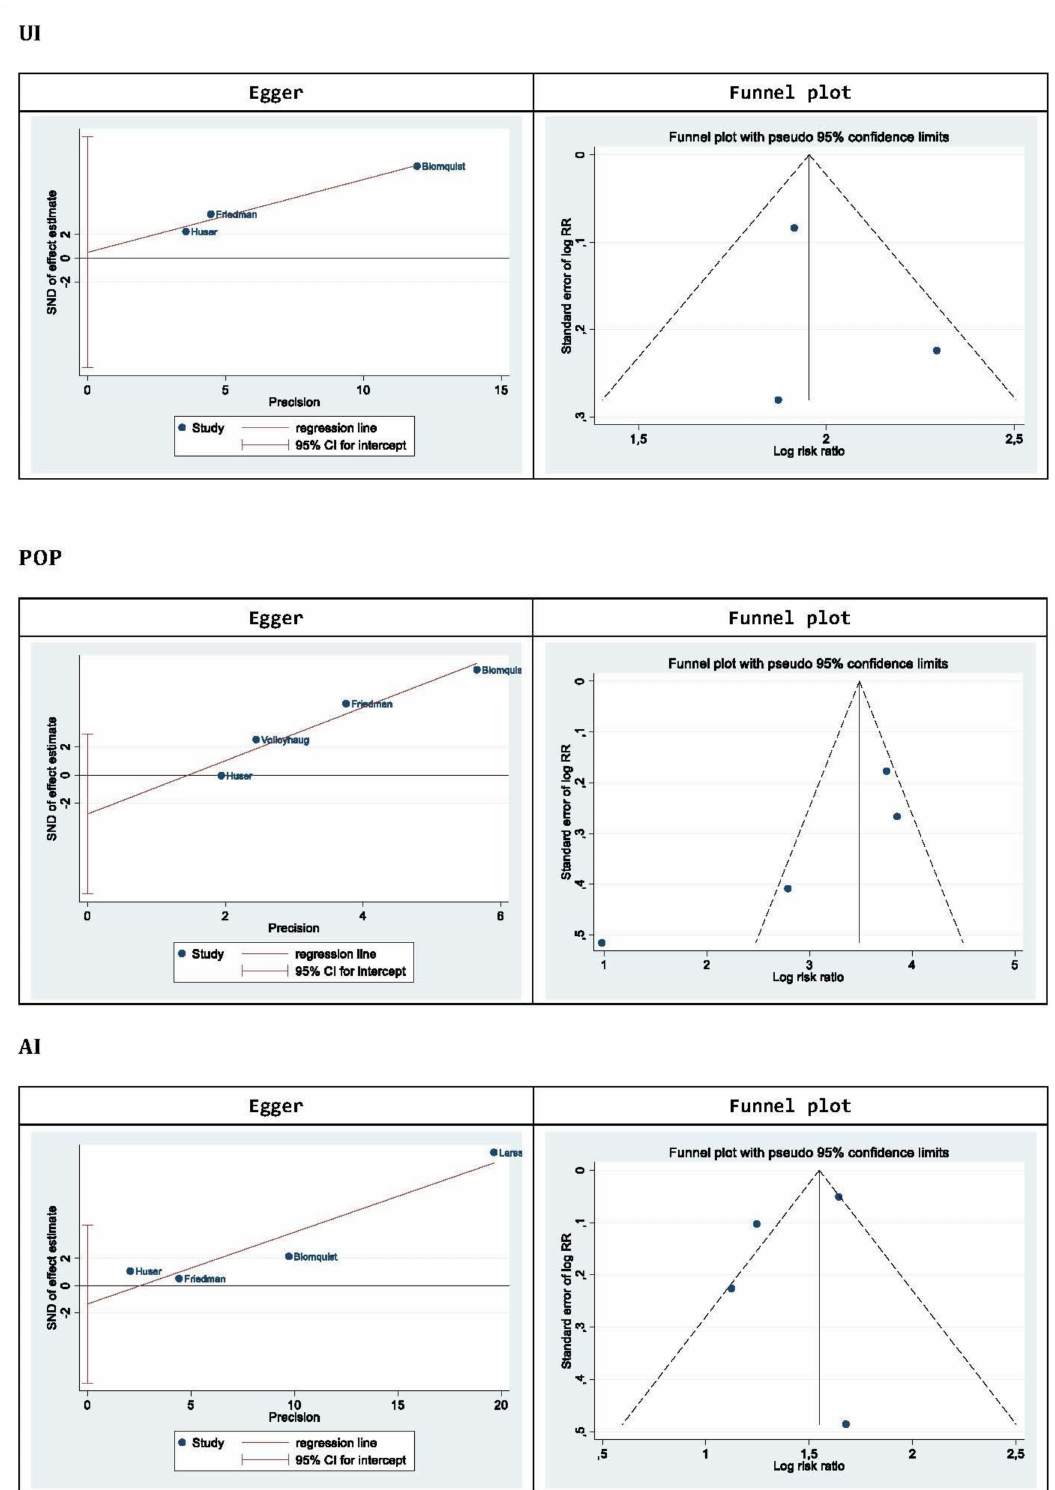
Figure 4. Publication risk of bias for meta-analysis